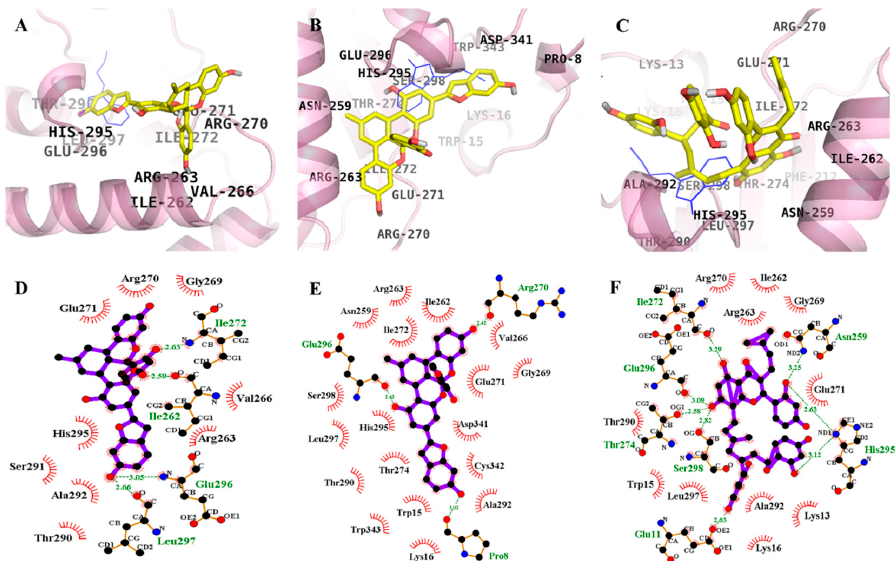
Figure 4. Molecular docking models for α -glucosidase inhibition at allosteric site by compounds 1 – 3 along with reported inhibitor BIP (blue line). 1 ( A ); 2 ( B ); and 3 ( C ). 2D ligand interaction diagram of α -glucosidase inhibition by 1 ( D ); 2 ( E ); and 3 ( F ). Schematic representation of interaction between ligands 1 – 3 and the α -glucosidase, thick purple stick models present the compounds 1 – 3 , green dotted lines are hydrogen bonds, and dashed half-moons present hydrophobic interactions with the corresponding amino acid residues of the enzyme. Int. J. Mol. Sci. 2018 , 19 , x FOR PEER REVIEW